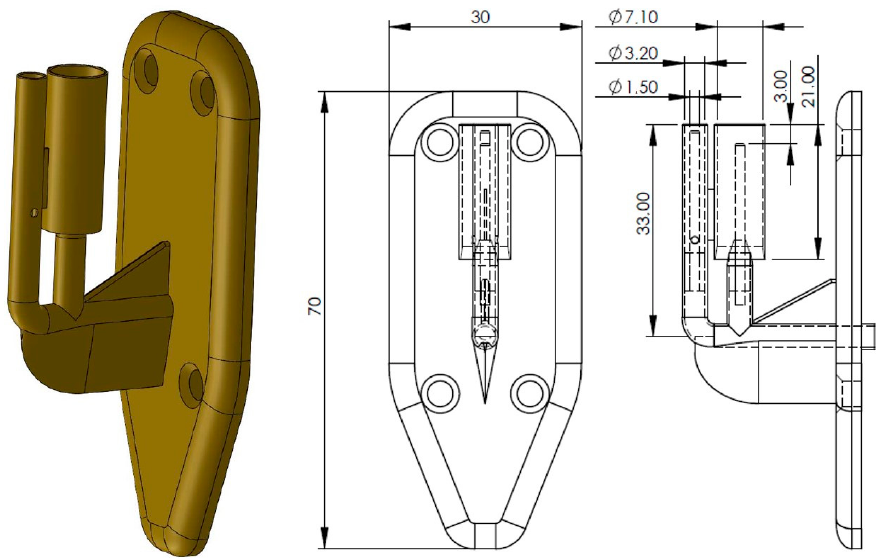
Figure 2. The final geometry of the proposed multi-element temperature probe for speed of flight measurement. ( Left ): 3D model, ( right ): main dimensions.